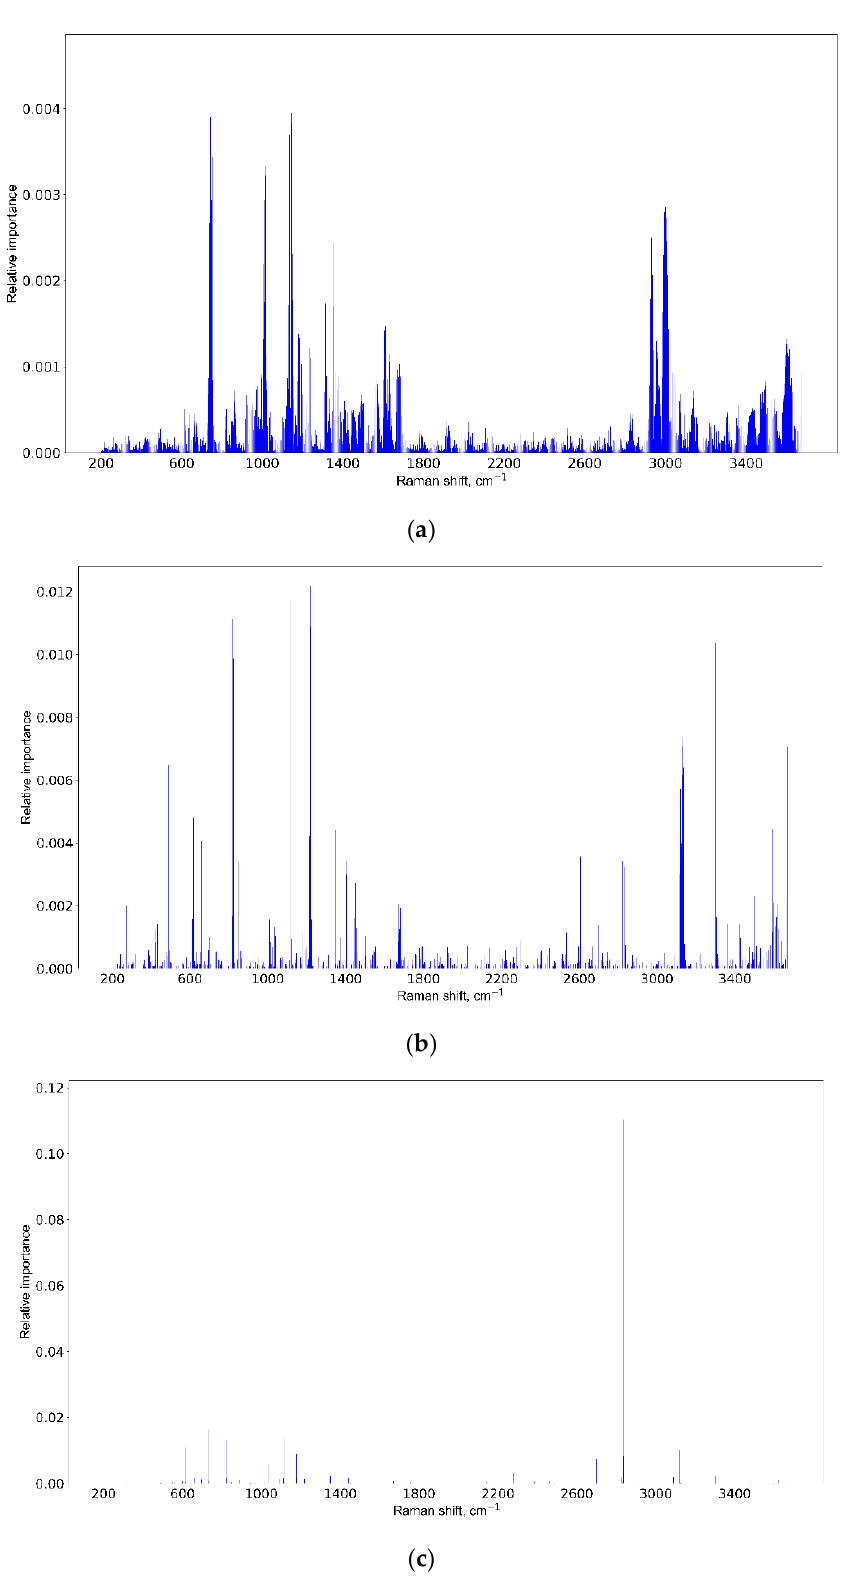
Figure 8. Informative feature selection for the third week of the experiment for SVM ( a ), RF ( b ), and XGBoost ( c )